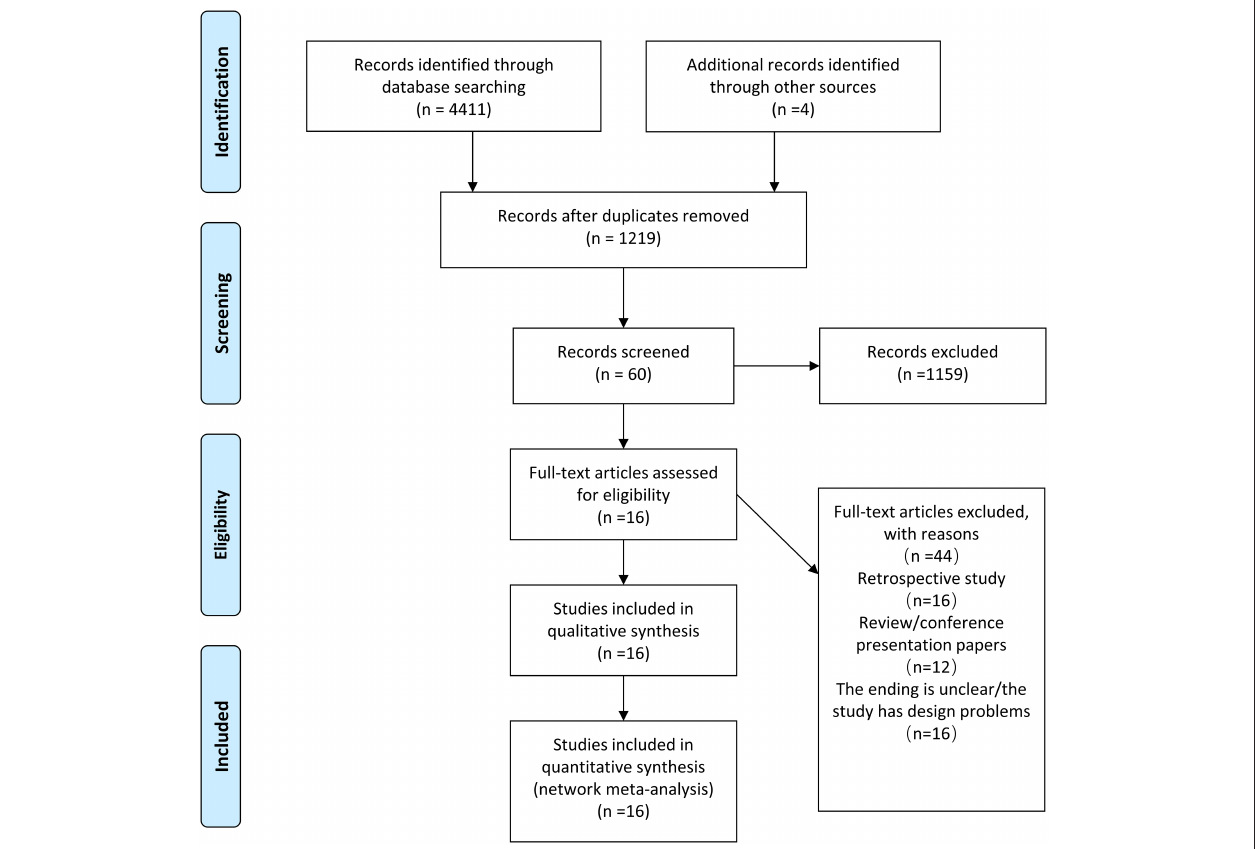
FIGURE 1 | Literature search and selection. The study process followed the PRISMA guidelines.